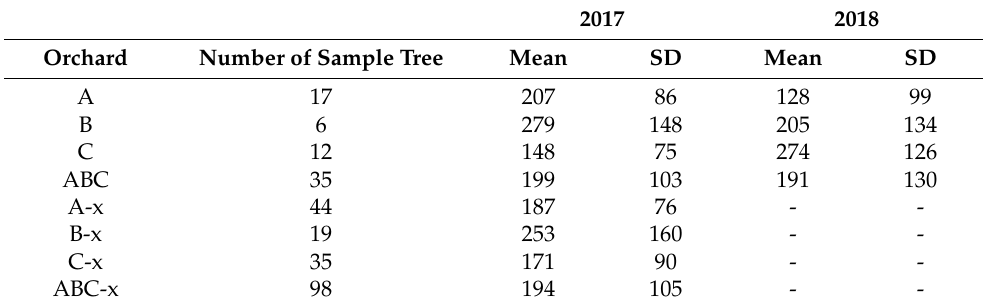
Table 2. Statistics on the harvest count of sample trees (fruit per tree) for each of two seasons. ABC represent the collection of sample trees from orchards A, B and